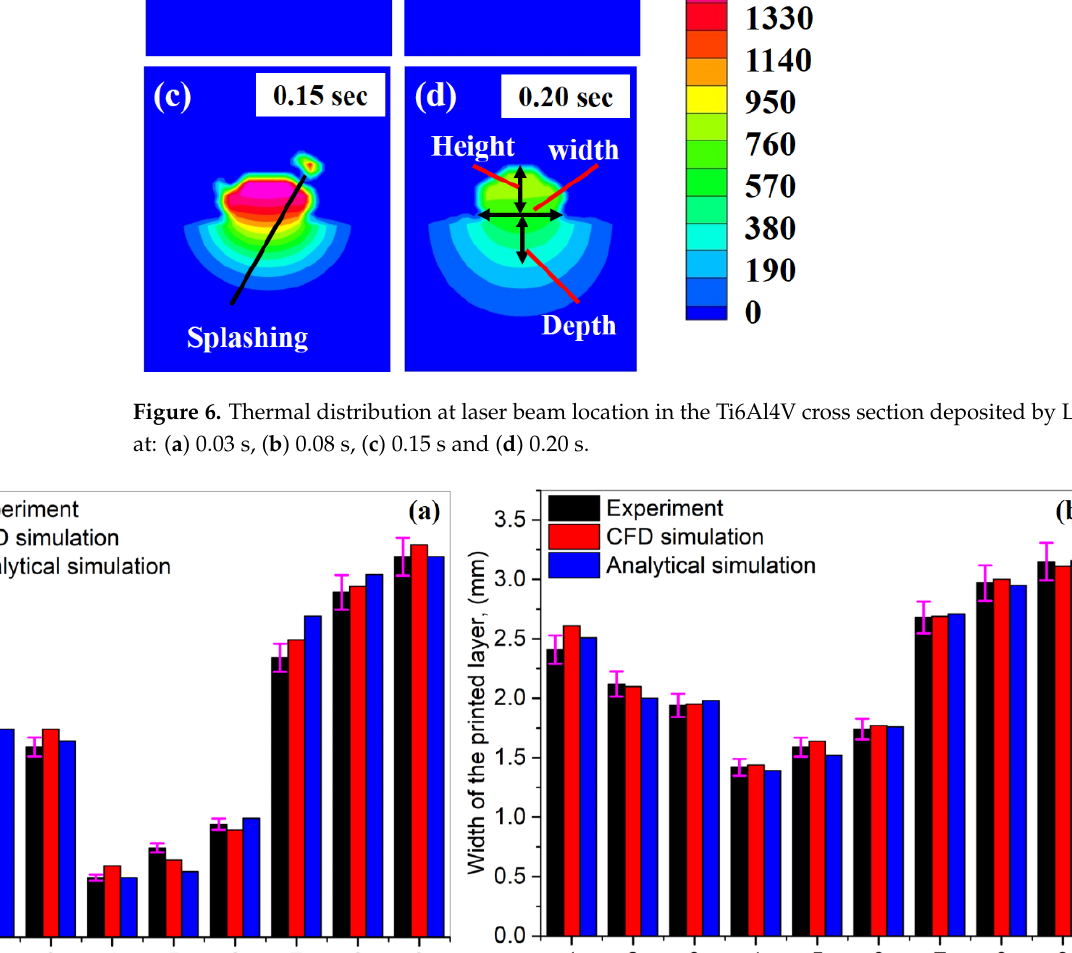
Figure 6. Thermal distribution at laser beam location in the Ti6Al4V cross section deposited by LMD at: ( a ) 0.03 s, ( b ) 0.08 s, ( c ) 0.15 s and ( d ) 0.20 s.